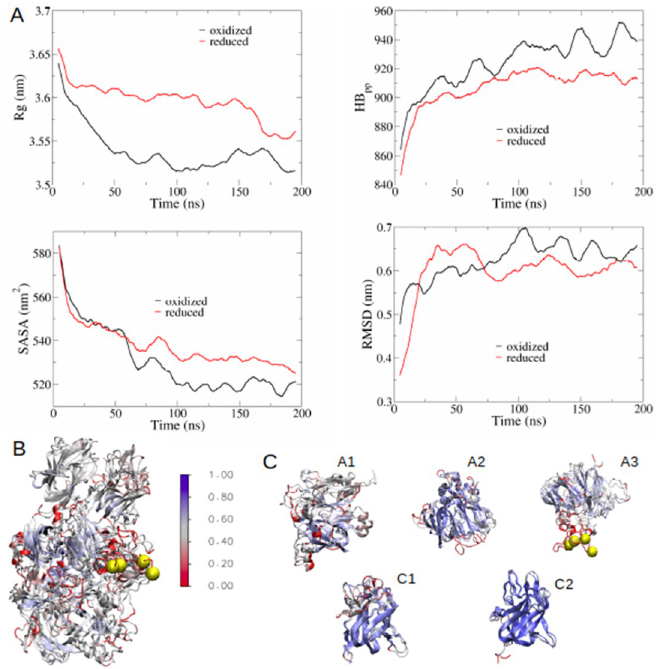
Fig 6. Modelled conformational changes in FVIII upon reduction of disulfide bond Cys1899-Cys1903. (A) Evolution of FVIII radius of gyration R g , number of intra-molecular hydrogen bonds HB pp , solvent accessible surface area SASA, and backbone RMSD with respect to the crystal structure, as function of simulation time, for both full- oxidized FVIII (black curve) and reduced FVIII (red curve). (B-C) Cartoon representation and superimposition of full- oxidized and reduced (Cys1899-Cys1903) FVIII. The alignment has been performed either on the whole structure (B), or on the separate domains (C). The cartoons are coloured according to the Q parameter, which is 1 for identical structures; the blue areas indicate structural similarity between full-oxidized and reduced FVIII, where Q = 1. Areas of poor structural similarity (Q = 0.1–0.3) are shown in red. The figure was obtained using the VMD software [59] and the STAMP algorithm [60], that works by minimizing the C α distance between aligned residues of each molecule. The Cys1899-Cys1903 disulfide bond is represented as yellow beads.